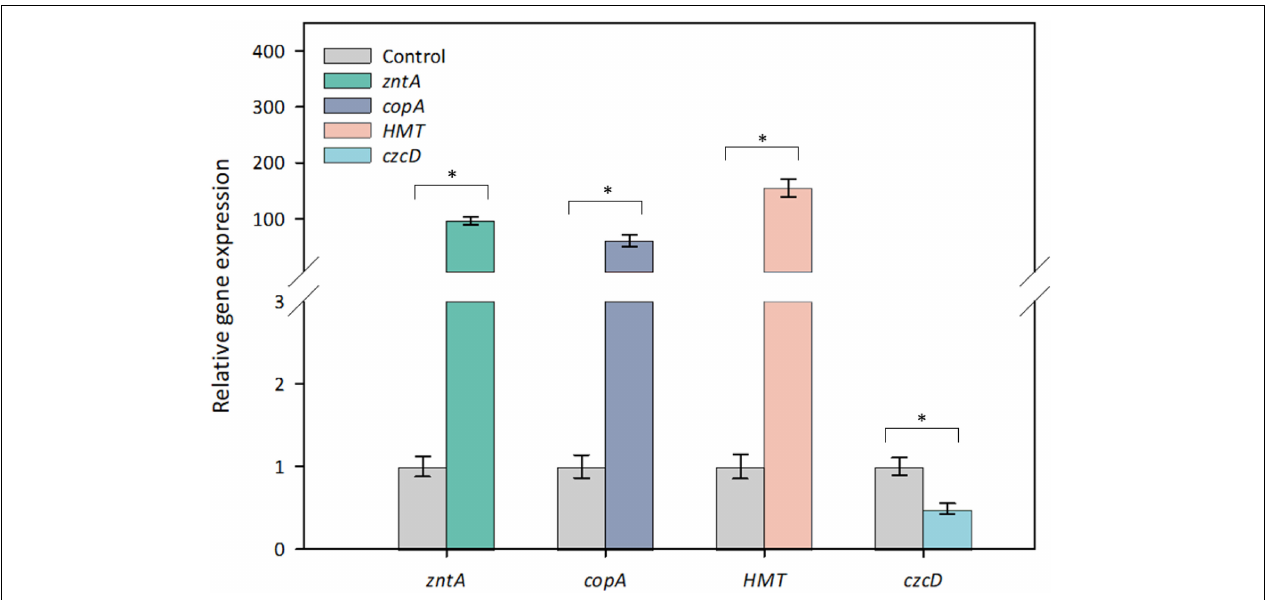
FIGURE 4 | Relative gene expression of the tested genes of strain Y8 in response to 4 mM Cd. Differences between paired values with 3 experiments that are statistically significant as determined by t -test are denoted as follows: ∗ p <